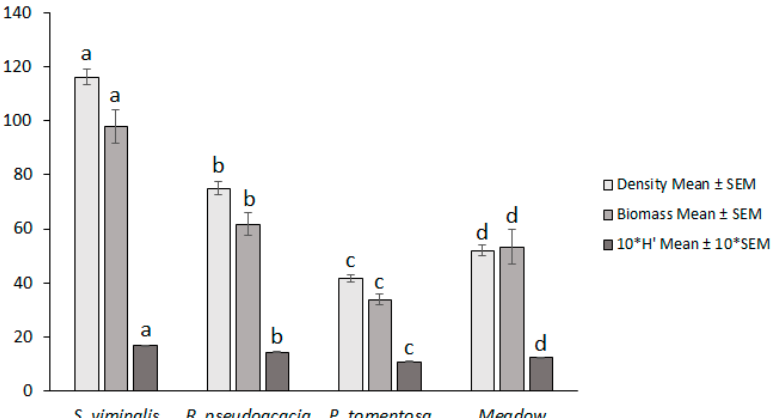
Figure 3. Effects of plant monocultures on density (ind. m − 2 ), biomass (g m − 2 ), and H’ index without consideration of sewage sludge influence ( H’ index was multiplied by a factor of ten for visibility). Different letters for a particular trait in different plant monocultures indicate statistically significant differences at p < 0.05.